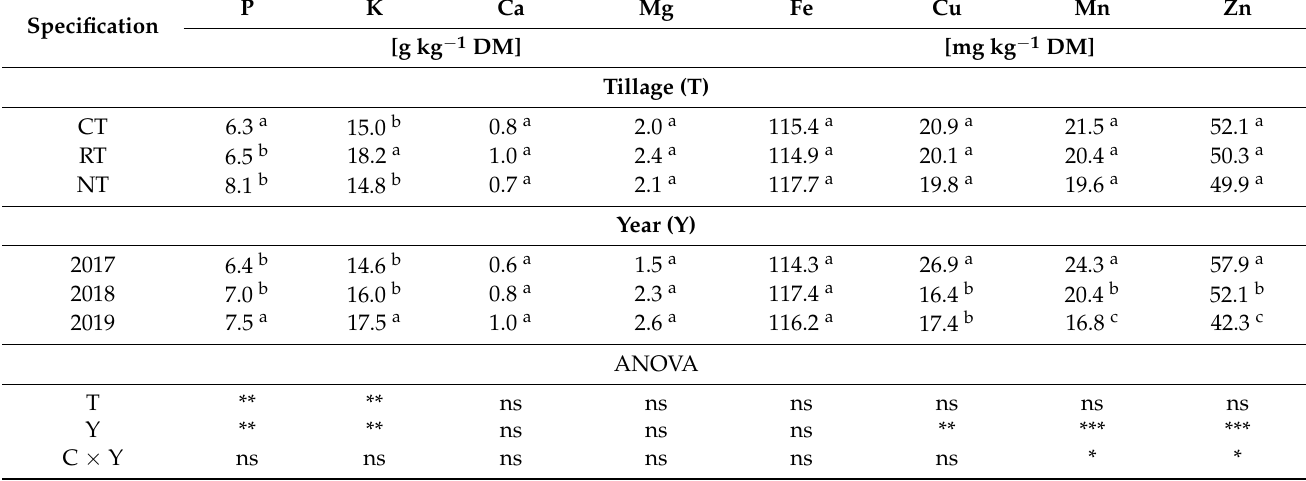
Table 5. Macroelement and microelement